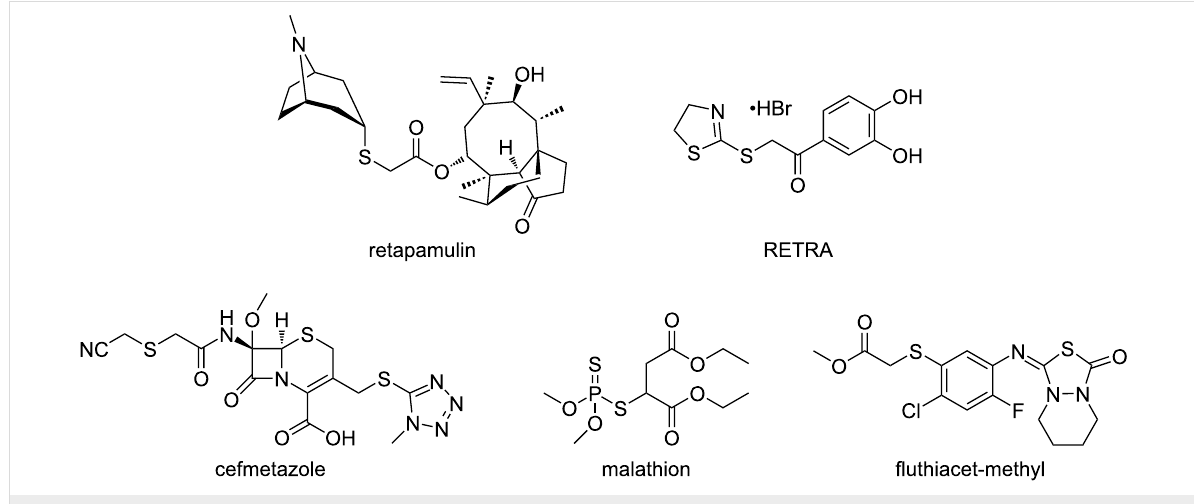
Figure 1: Drugs and agrochemicals containing the α -thiocarbonyl core as a structural